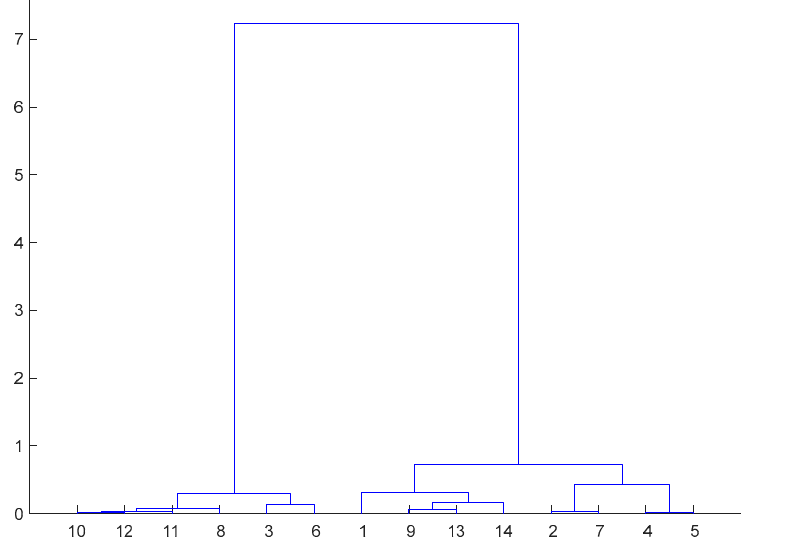
Figure 4. Dendrogram plot showing similarities and correlations among different fourteen studied cultivars.